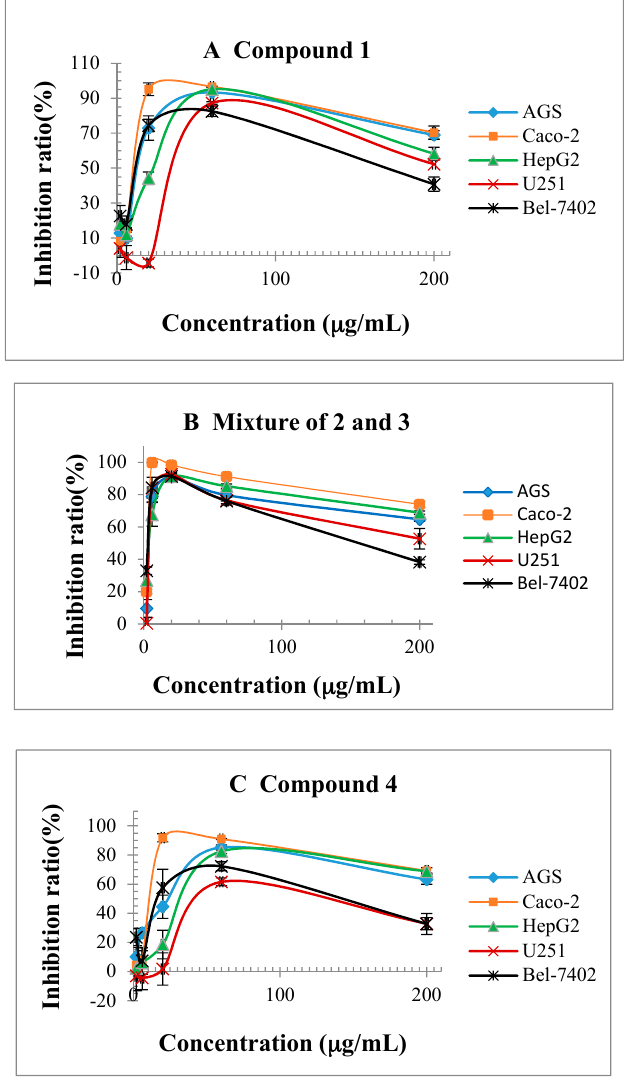
Figure 4. Inhibition of main compounds from TDS for testing cell lines: ( A ) Compound 1 ; ( B ) Mixture of 2 and 3 ; ( C ) compound 4.